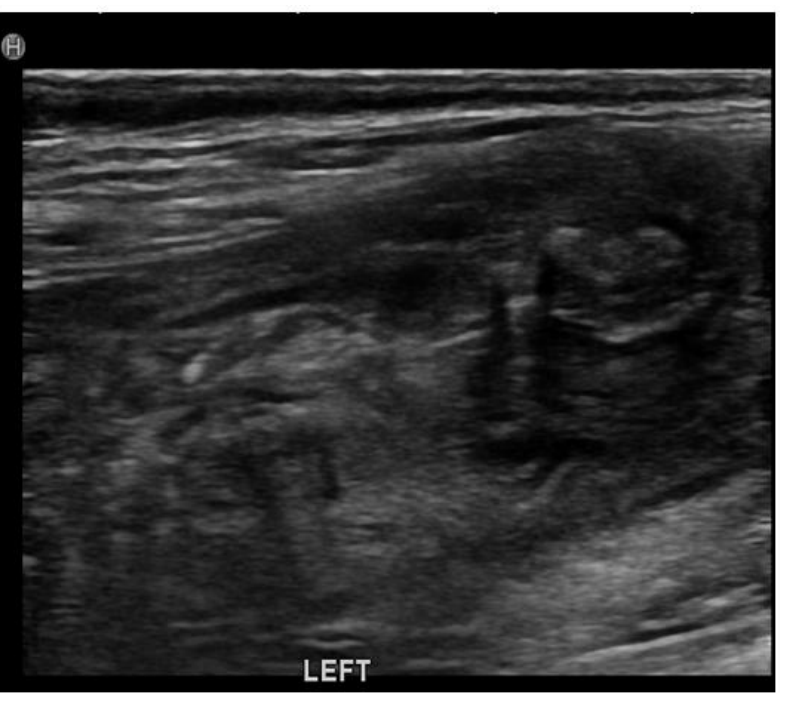
Figure 5 : Alteration of the Musculotendinous Junction (MTJ) Longitudinal view of the musculotendinous junction The musculotendinous junction of both the GT and the SDF were significantly altered with lack of normal muscle of fibre tendon. Several hyperechoic fibs were ‘’coiled up’’ amongst the altered muscle tissue which may be representing retracted tendon fibs from a distal rupture in addition to a MTJ rupture. Evaluation of the bursa was performed while investigating the insertion of the common tendon. Mild amount of hyperechoic changes within the common tendon bursa was frequently identified as normal age-related changes (see figure 4 B). Minor hyperechoic fibrous changes within the tendons were also typically age- related. A diagnosis of bursitis was indicated by the presence of anechoic fluid at the point of insertion at the calcaneus along with calcification and fibrous changes within the bursa to a greater degree than the contra- lateral side, in addition to no other tendinous insertion fibre changes (see figures 2 B and